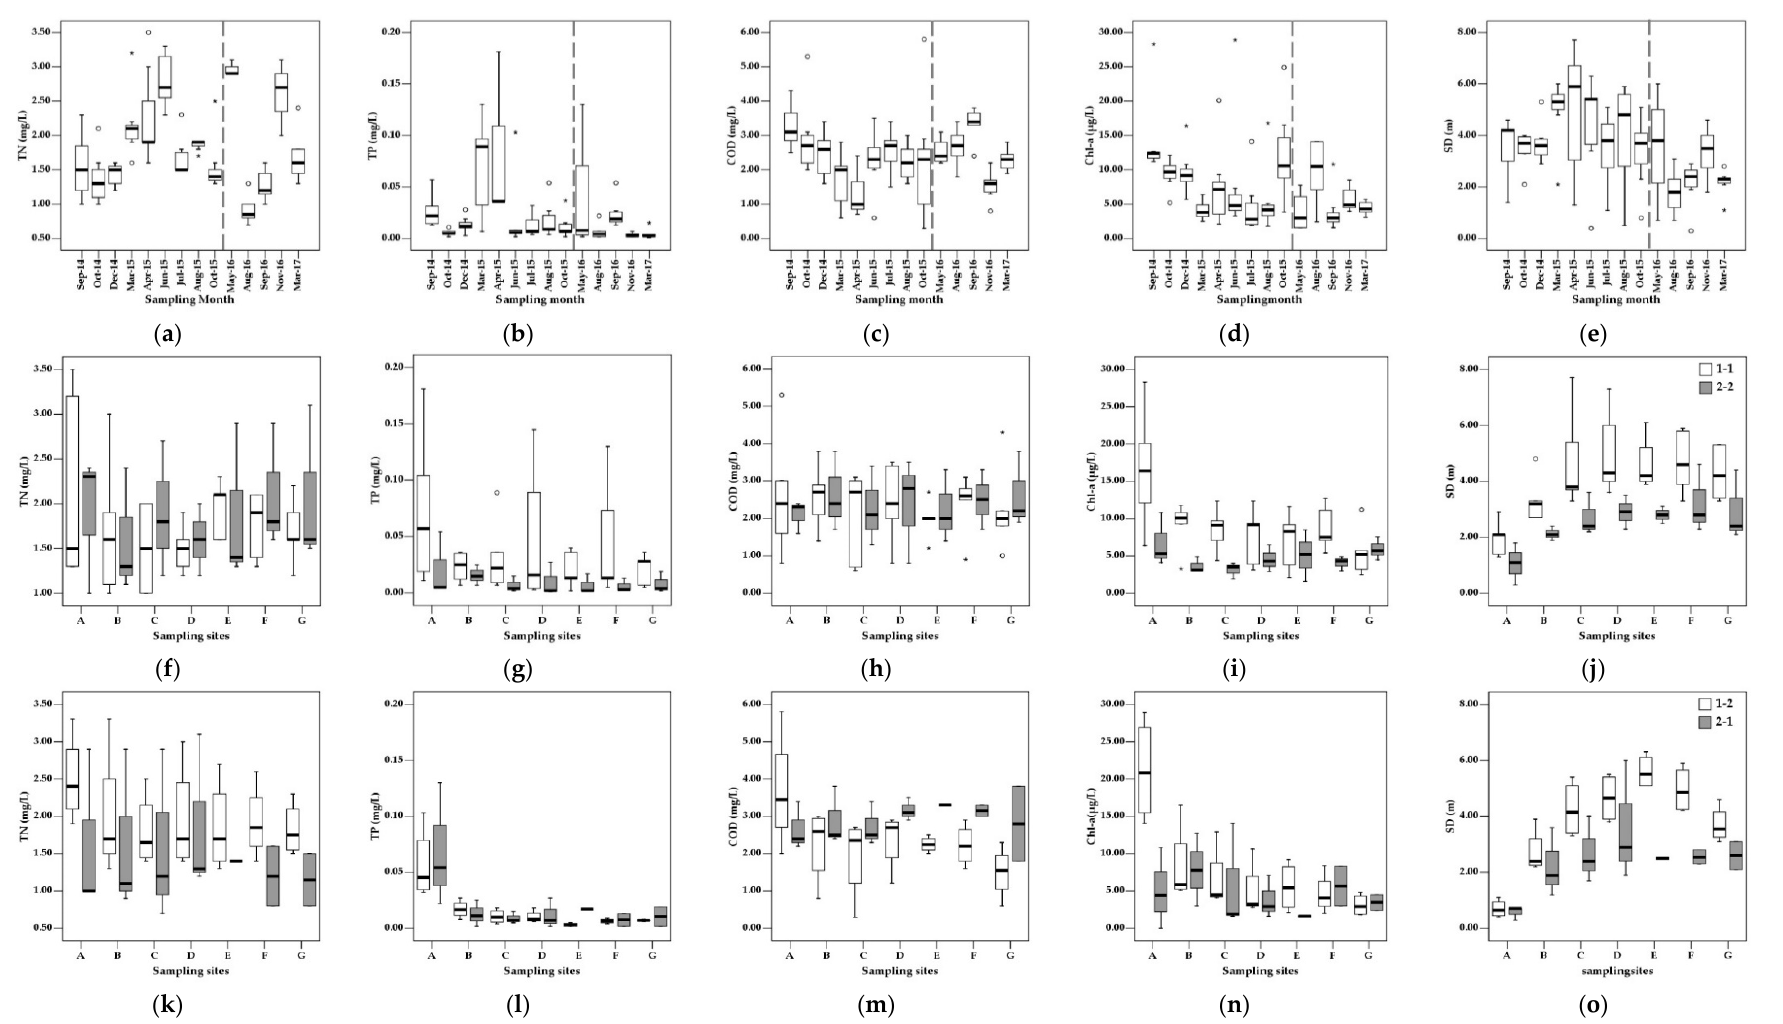
Figure 3. Box-and-whisker plots showing spatial distribution and average values in each sampling event ( a – e ) and temporal distribution and average values at each location ( f – j ; subperiod 1-1 and 2-2, k – o ; subperiod 1-2 and 2-1) of total nitrogen (TN), total phosphorus (TP), chemical oxygen demand (COD), chlrophyll a (Chl- a ), and Secchi depth (SD). The dotted lines in a–e were inserted for the division between the two sampling periods.